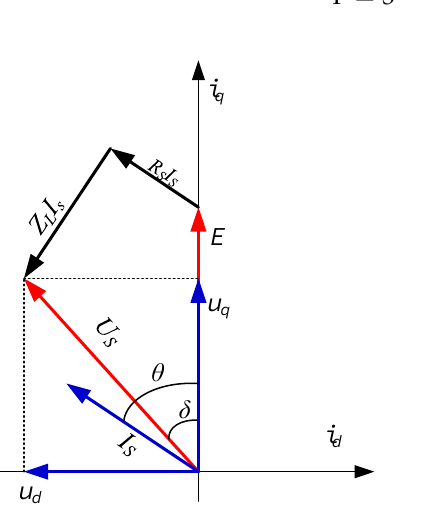
Figure 4. Vector diagram of the voltages on the stator winding in the current plane in the dq axis.